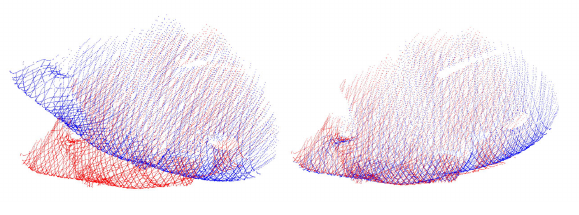
Figure 4: Point clouds before and after approximate registration.